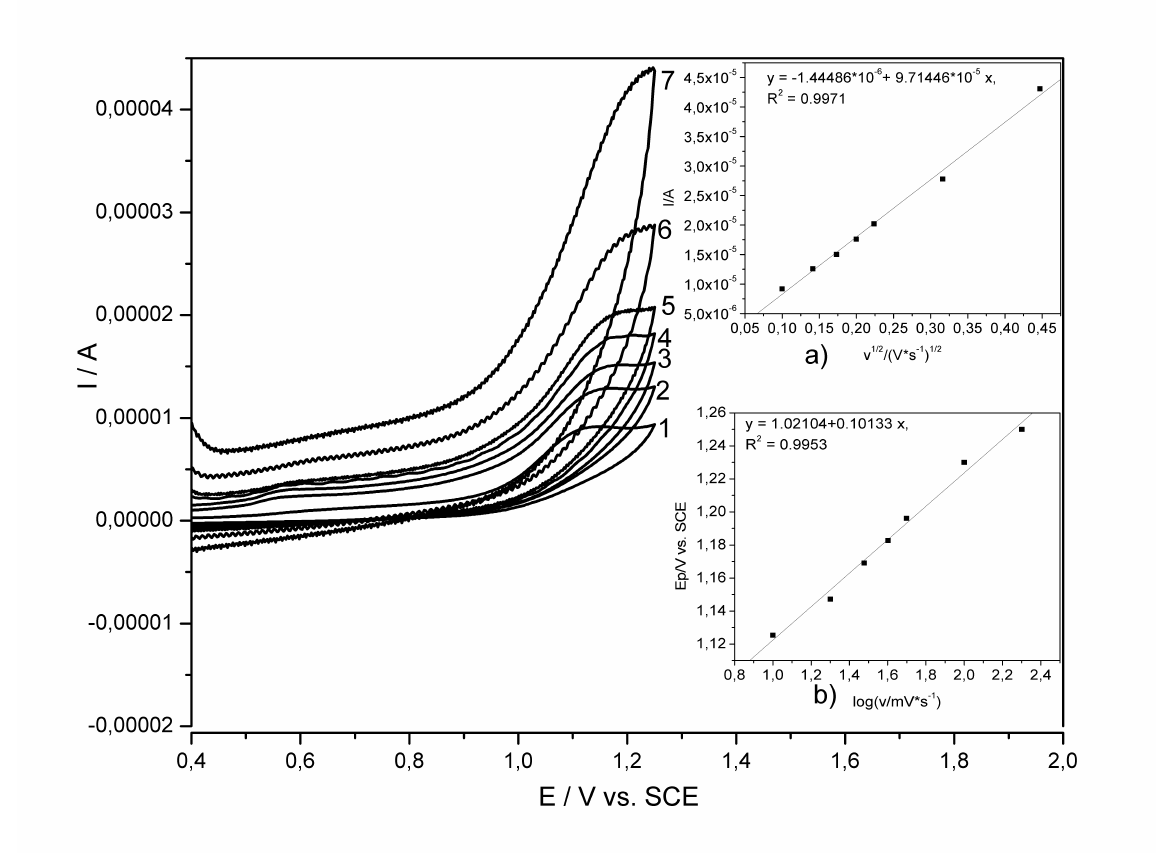
Figure 3. Cyclic voltammograms (3 rd scan) of 1 mM oxalic acid at EG-PS with different scan rates in SO ; 1-0.01Vs -1 ; 2-0.02 Vs -1 ; 3-0.03Vs -1 ; 4-0.04Vs -1 ; 5-0.05 Vs -1 ; 6-0.1 Vs -1 ; 7-0.2 Vs -1 ; 0.1 M Na 2 4 Inset a-The anodic peak current I vs. v 1/2 ; Inset b- Dependence of the potential of current peak, E p the log